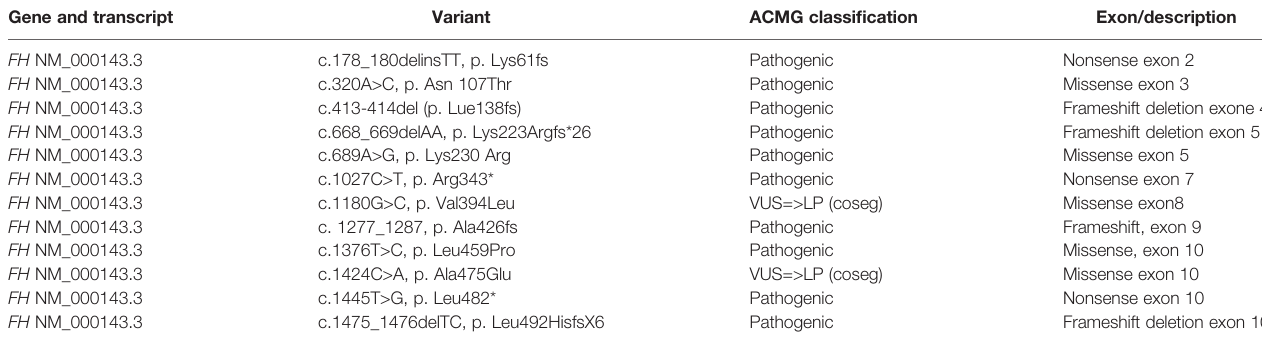
TABLE 4 | Heterozygous FH variants identi fi ed on clinically accredited diagnostic